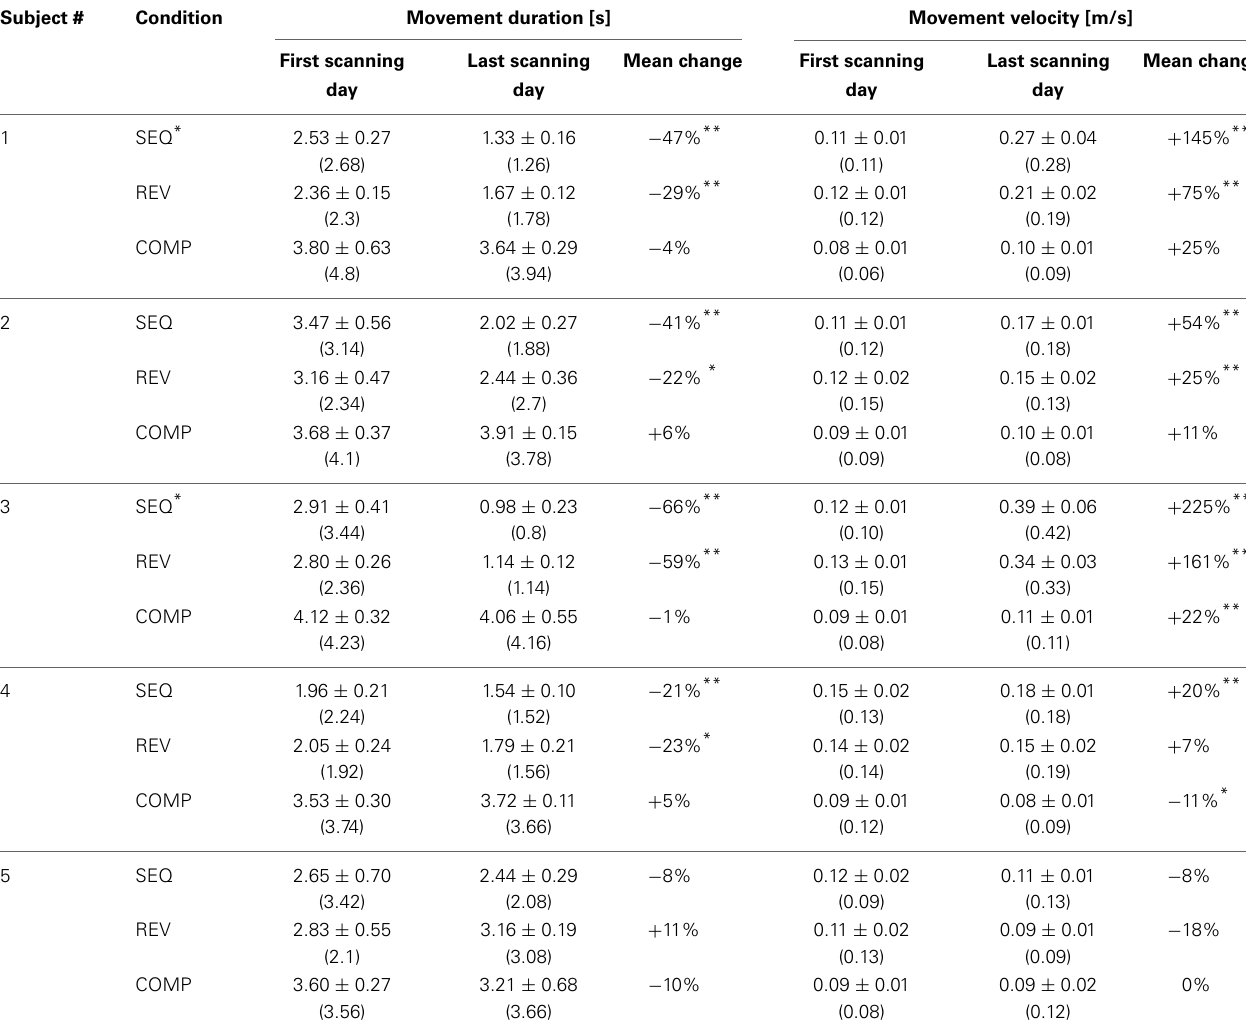
Table 1 | Dependency of trial duration and trial mean velocity on the acquisition of the co-articulation motion